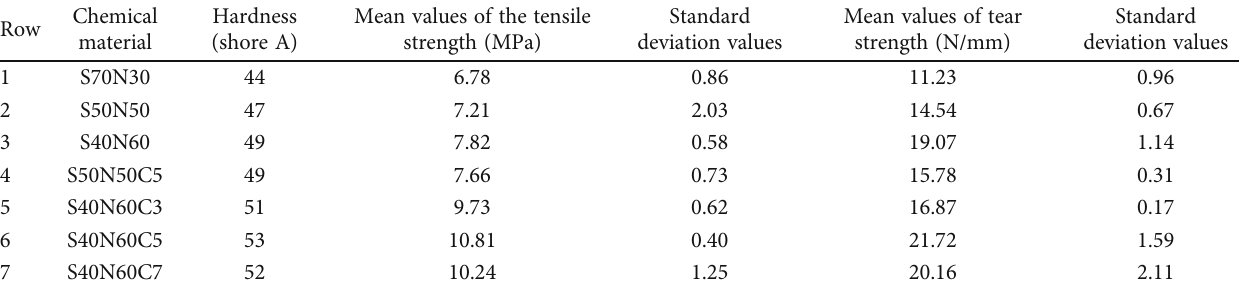
Table 3: Mechanical properties of di ff erent rubber